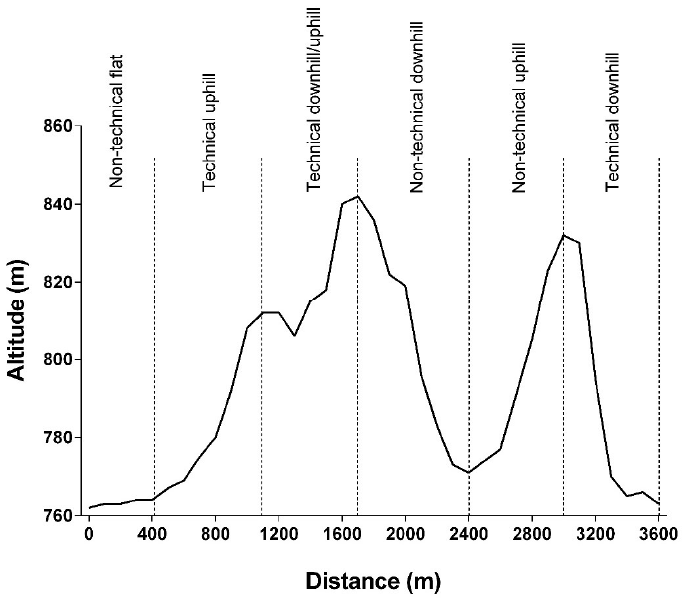
Figure 4. Example of an XCO circuit profile with the location of each track section for an individual lap.